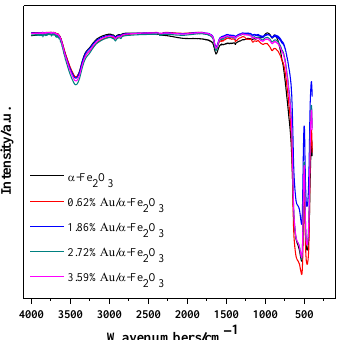
Figure 5. The Fourier transform infrared (FTIR) spectra of α-Fe 2 O 3 and Au/α-Fe 2 O 3 catalyst calcined at 300 °C.